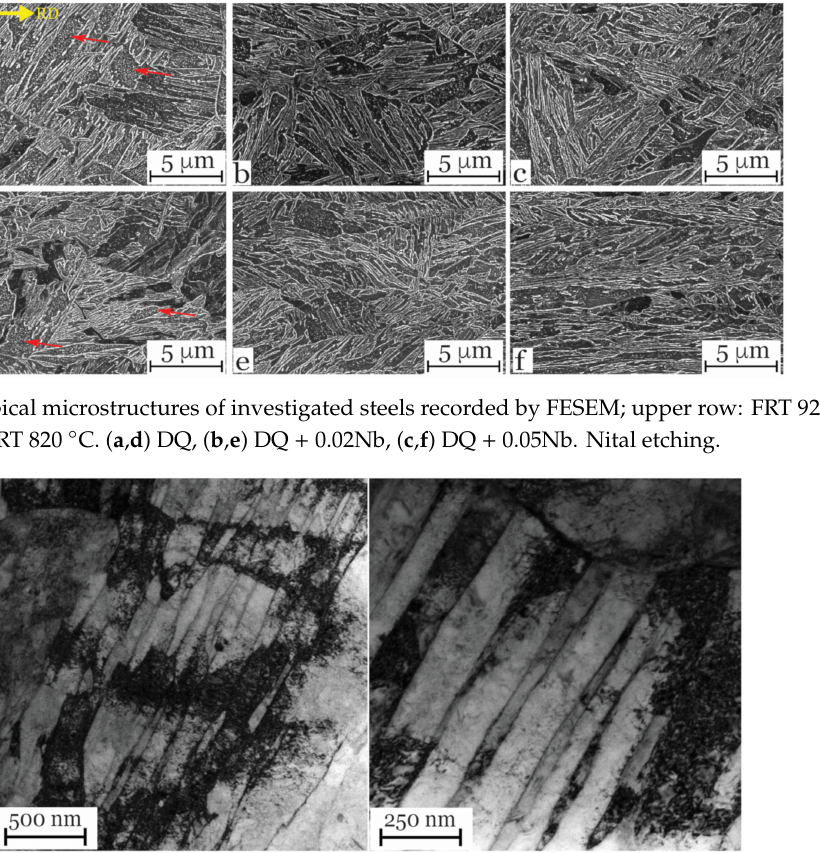
Figure 10. Transmission electron microscopy (TEM) microstructures of DQ + 0.02Nb steel with FRT of 820 ◦ C.